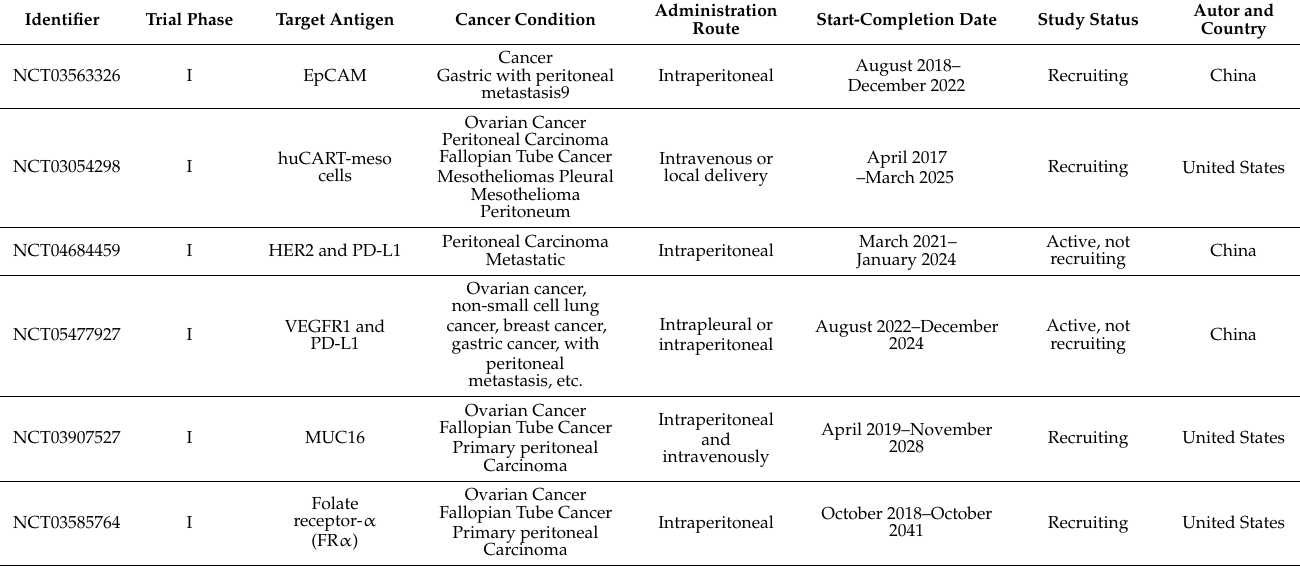
Table 4. Current clinical studies of CAR-T cell therapy for peritoneal carcinomatosis (source: clinicaltrials.gov) (accessed on 25 February